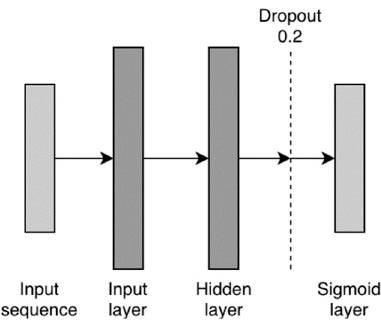
Figure 3. The set of stacked layers that together form the BoW classification architecture.